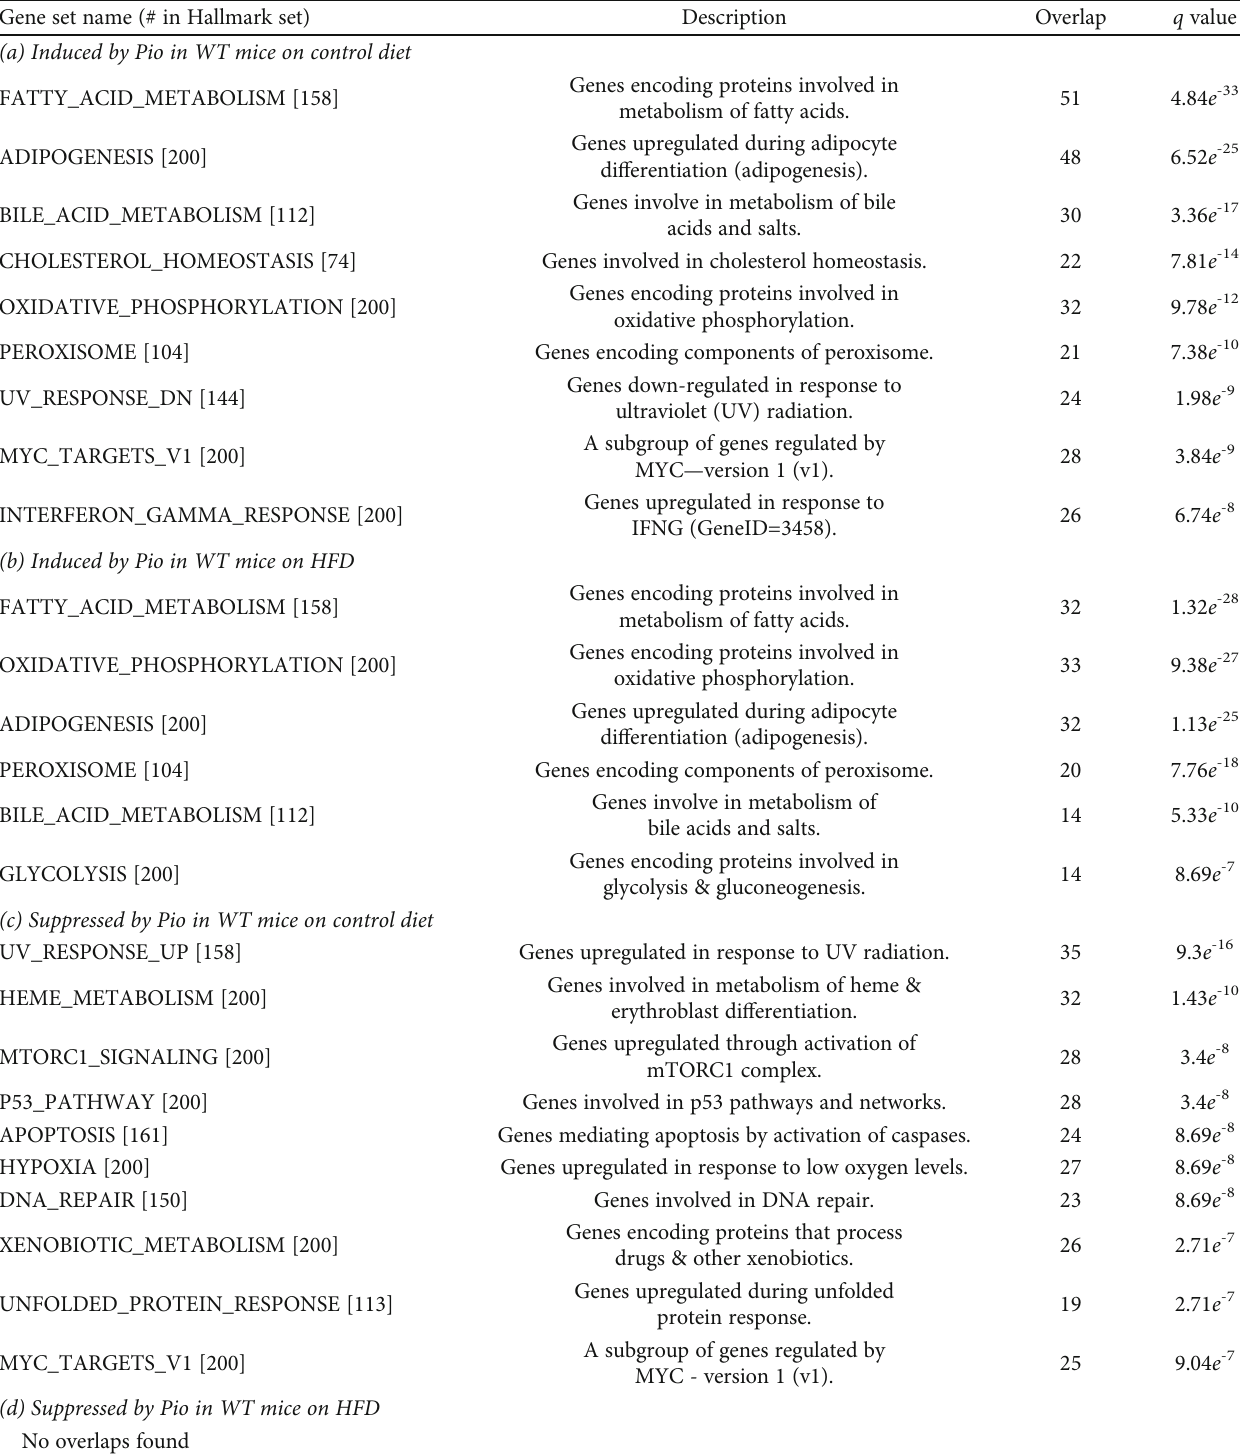
Table 1: Gene set analysis ∗ on RNA-Seq data from WT Pio-treated vs. Pio-untreated mice on control or HFD (as designated). Gene set name (# in Hallmark